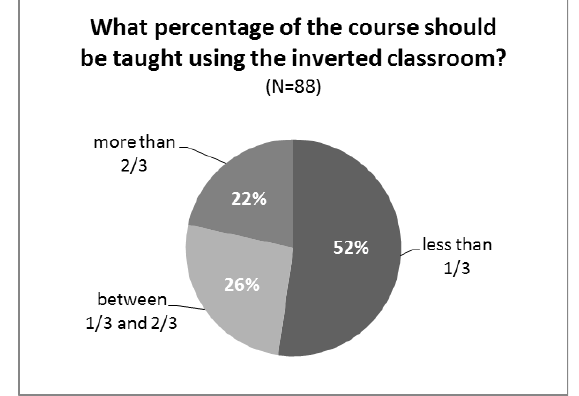
Figure 3. More than half of the students think that less than 1/3 of a course should be taught using the inverted classroom. This was an open question with the original title “Welcher Anteil einer Lehrveranstaltung innerhalb eines Semesters sollte in dieser neuen Form durchgeführt werden (0% bis